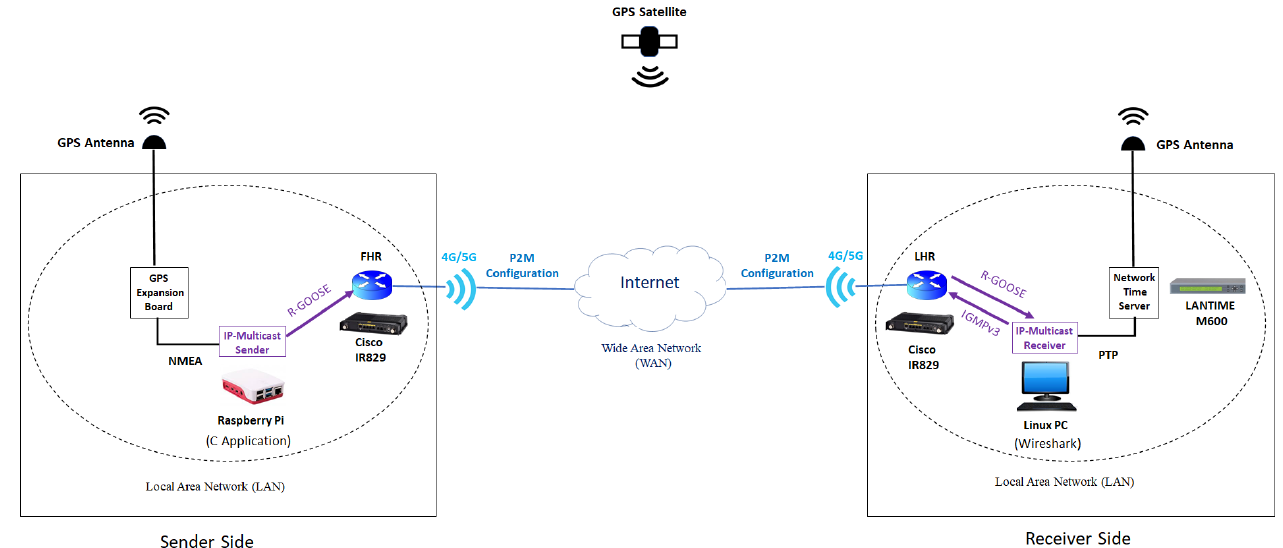
Figure 19. Test setup for communication latency measurement of R-GOOSE messages.